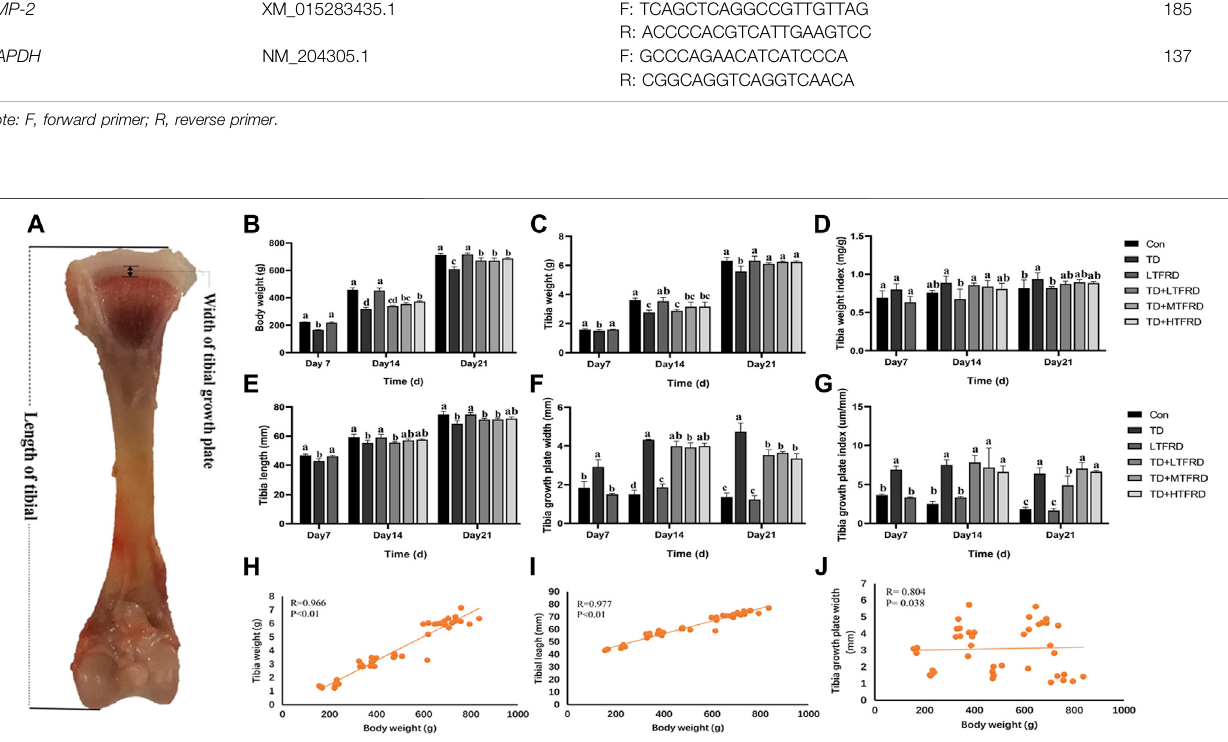
Frontiers in Pharmacology |